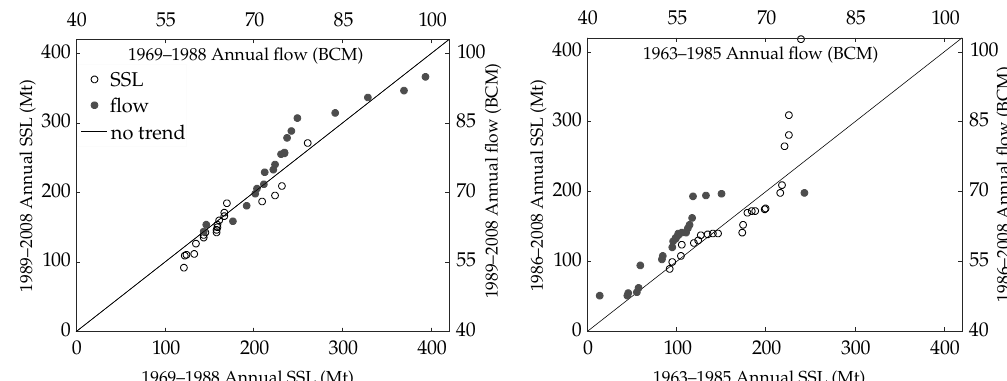
Figure 6. Results of innovative trend test showing a decreasing trend in low and high annual SSLs and flows at the Besham Qila and an increasing trend in high annual SSLs at Partab Bridge, along with an increase in all flows (legends for ( a ) also apply for ( b